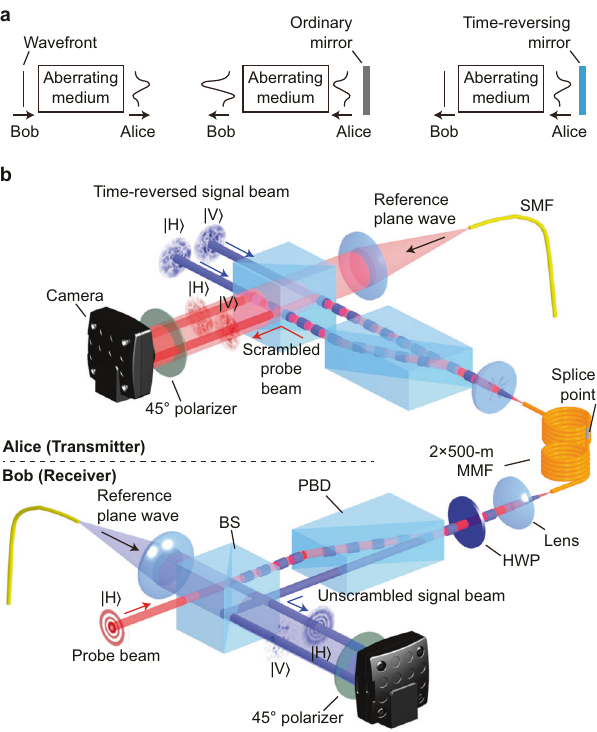
Fig. 1 Illustration of experiment. a The concept of time reversal. b Schematic of the experiment to send high- fi delity spatial modes from Alice to Bob. Bob fi rst transmits a probe beam to Alice (denoted by red beams). Alice performs vectorial off-axis holography on her received probe beam and generates the corresponding time-reversed signal beam (denoted by blue beams). H j i and V j i stand for the horizontal and vertical polarization state, respectively. HWP: half-wave plate. PBD: polarizing beam displacer. SMF: single-mode fi ber. BS: beamsplitter. See Supplementary Note 2 for experimental